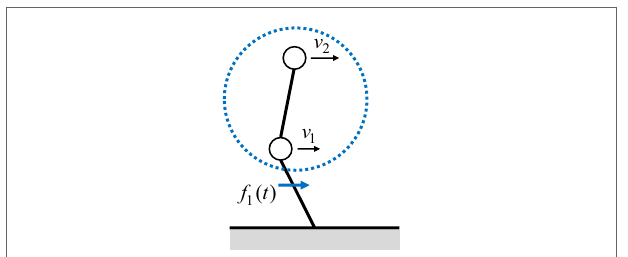
FigUre 8 | Tangential line of the ellipse ( / 2) + ( / 2) 1 12 2 22 m v m v D == at the point ( v 10 , v 20